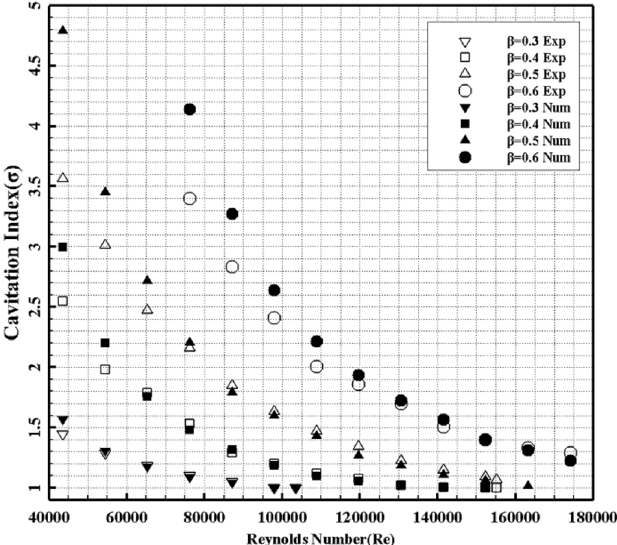
Fig. 18. Comparison of the resulted cavitation number variation for different ori fi ces in the numerical and experimental experi- ments.